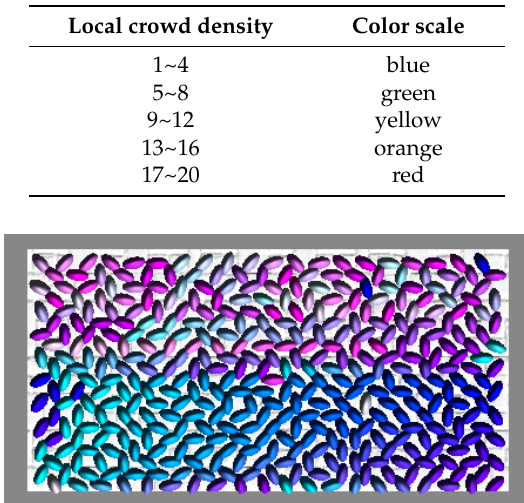
Figure 1. A total of 400 agents are represented with different colors. During simulation the bottom wall moves towards the top wall.